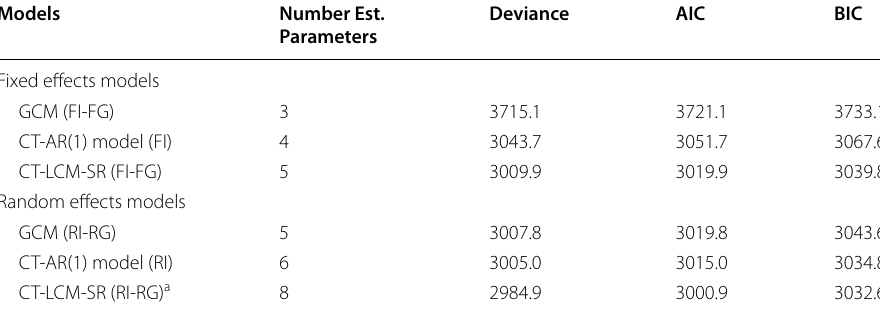
Table 2 Comparison of fit indices in models fitted to PISA data